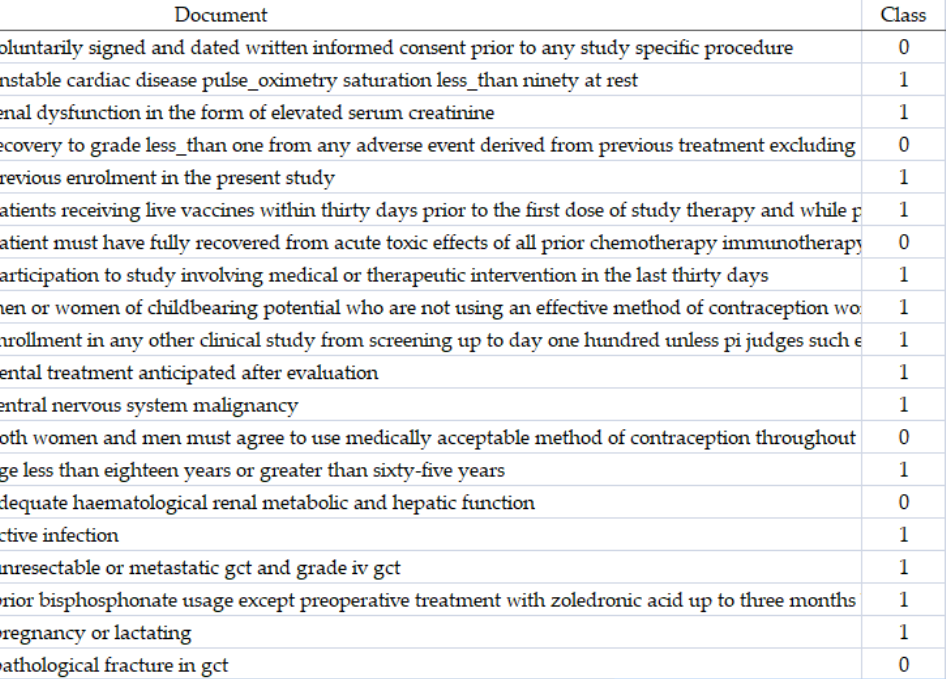
Figure 2. Snippet of clinical trial dataset.